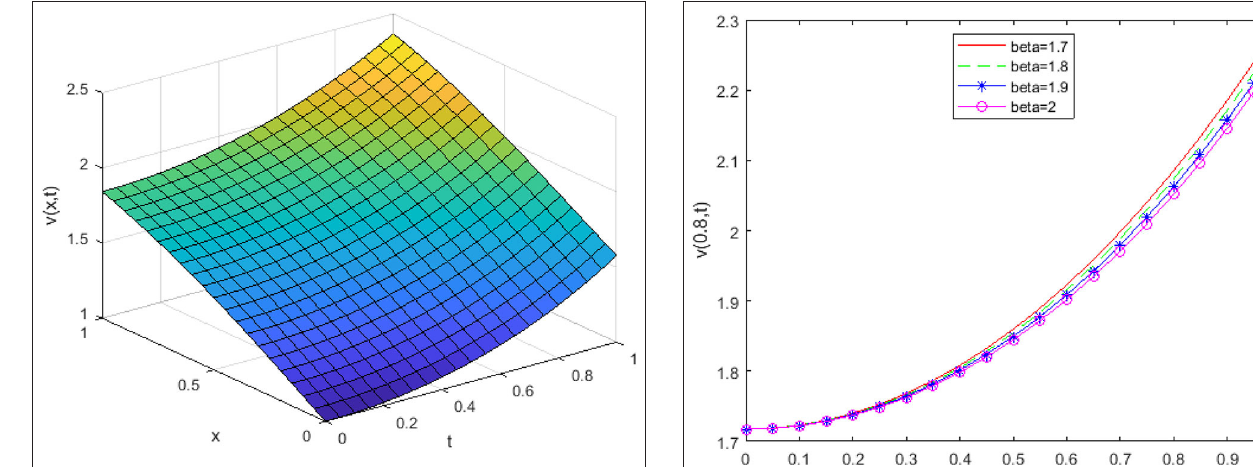
FIGURE 1 | Approximate solution at β = 2.